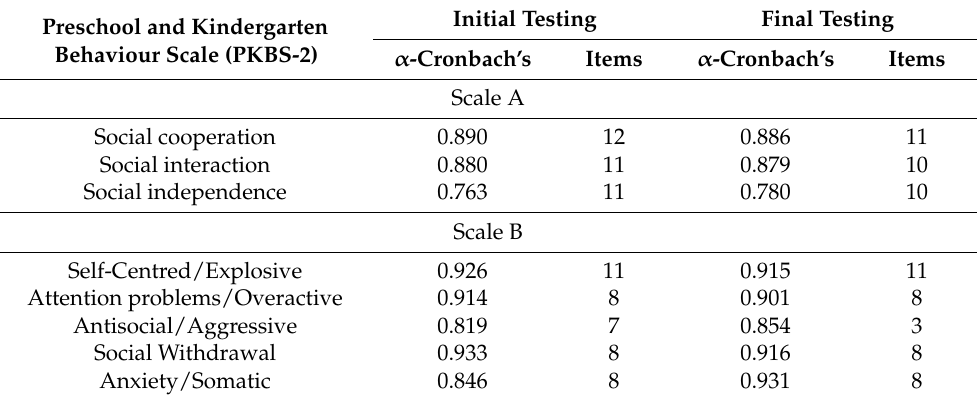
Table 1. Reliability analysis for scale A and scale B of the PKBS 2 questionnaire.